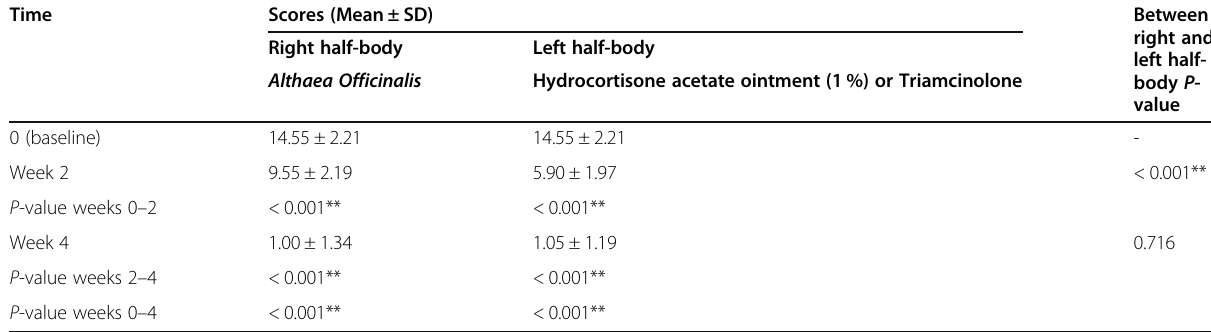
Table 2 Mean scoring of Atopic Dermatitis (SCORAD) in the active treatment group